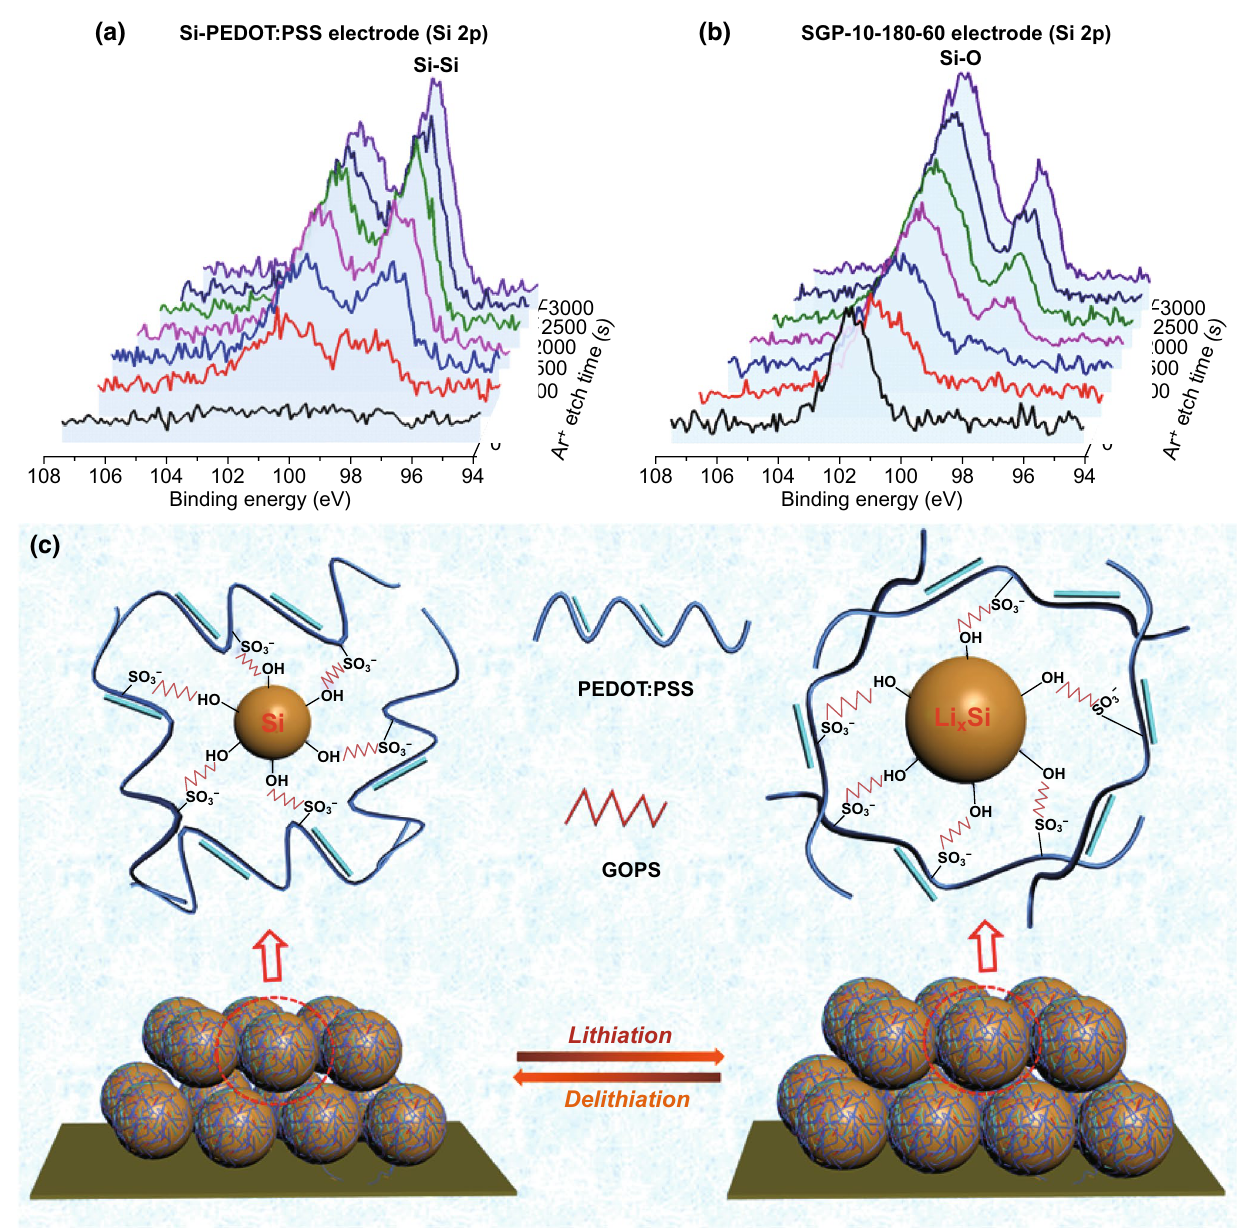
Fig. 6 Si 2p spectra of XPS Ar + etching depth analysis of a Si-PEDOT:PSS and b SGP-10-180-60 electrodes after 100 cycles at 2.0 A g −1 . c Schematic illustration of the proposed mechanism explaining the electrochemical performance of SGP-10-180-60